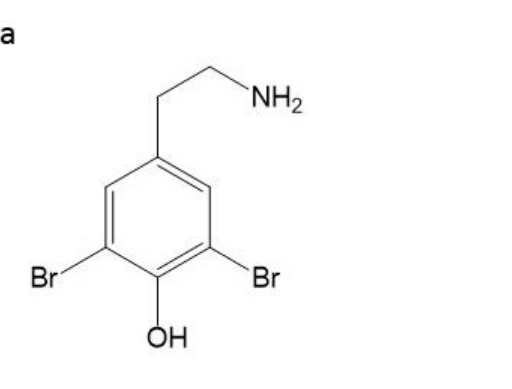
Figure 3. Bromophenol compounds from marine algae with antifungal activities against A. fumigatus. ( a ) 2,20,3,30-tetrabromo-4,40,5,50 tetrahydroxydiphenylmethane and ( b ) 3-bromo-4- (2,3-dibromo-4,5-dihydroxybenzyl)-5